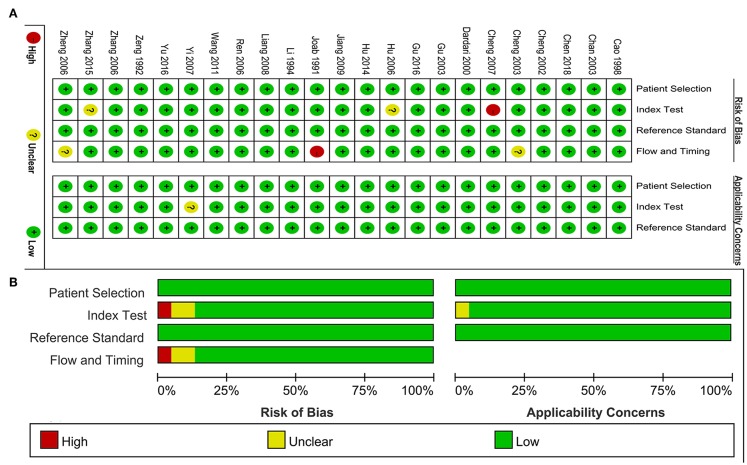
Quality assessment of included study. (A) Review authors' judgements about each domain presented as percentages across included studies. (B) Review authors' judgements about each domain for each included study.